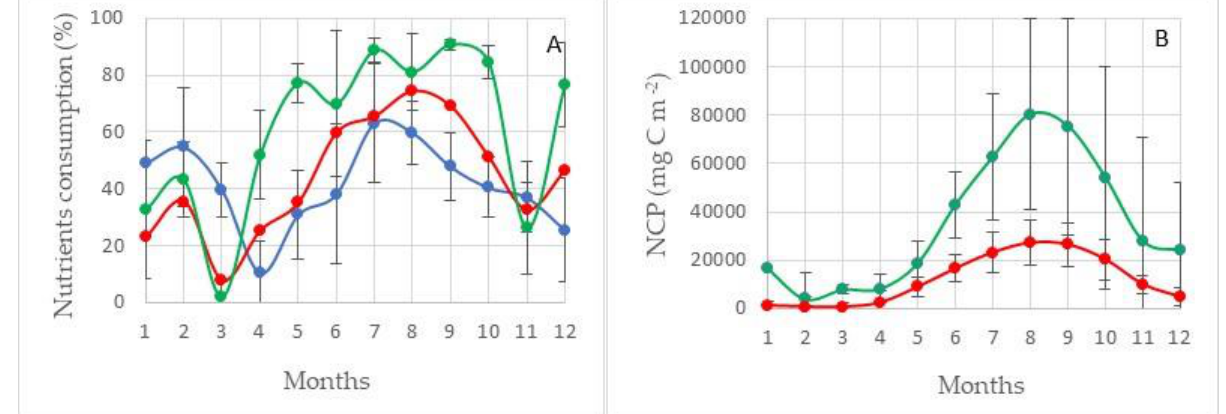
Figure 12. Annual cycle of primary production and nutrient consumption ( A ) and primary produc- tion ( B ) in Region V; ( A ) is the consumed part of the nutrient supply in the process of photosynthesis (blue: mineral phosphorus, red: mineral nitrogen, green: silicon); ( B ) primary production (green: NCP Si ; red: NCP N ).